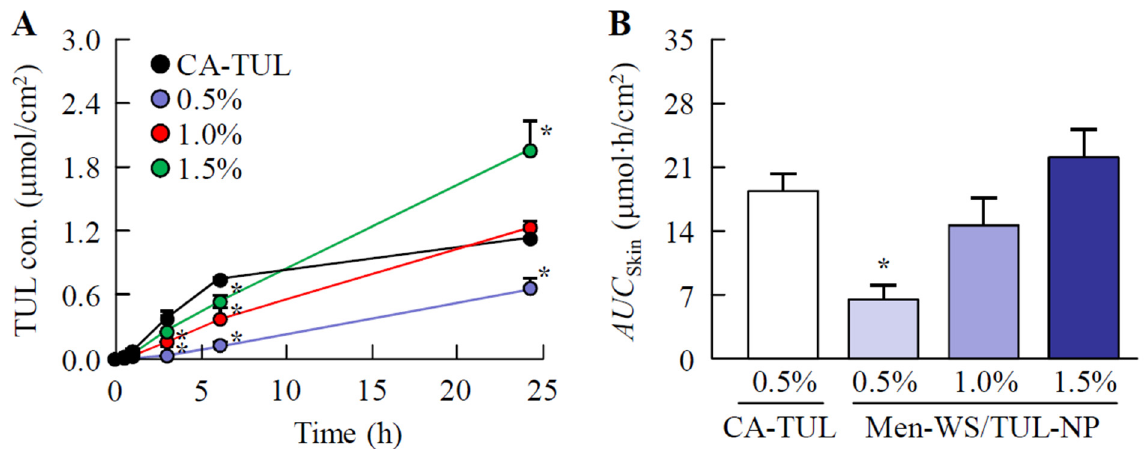
Figure 5. Changes in the transdermal penetration of TUL in Men-WS/TUL ointments containing 0.5–1.5% TUL-NPs. Changes in TUL profiles ( A ) and AUC Skin values ( B ) of Men-WS/TUL-NP oint- ments (0.5–1.5% TUL). Results are means ± SE; n = 6–8. * p < 0.05 vs. CA-TUL tape for each category. The transdermal penetration of TUL in Men-WS/TUL-NP ointment was enhanced with TUL con- tent, and the penetration profile linearly